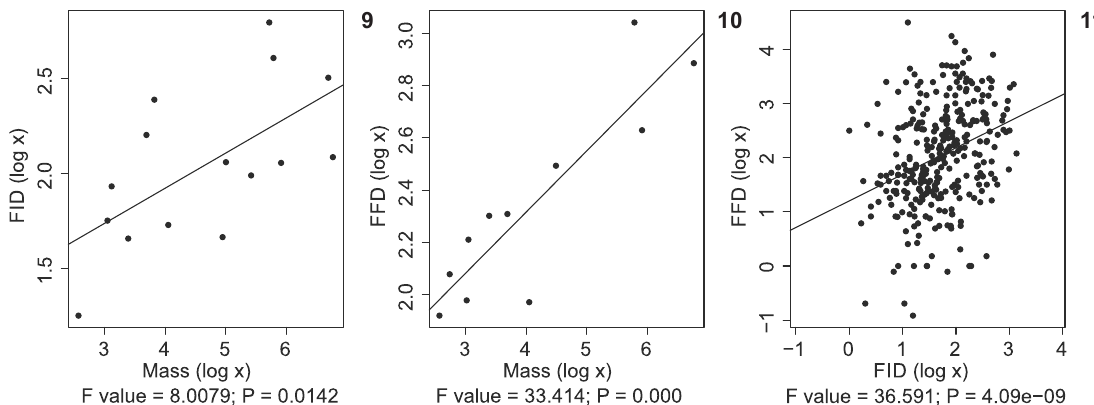
Figures 9-11. Linear regression for (9) Body mass x FID; (10) Body mass x FFD and (11) FID x FFD. Body mass from D UNNING -J R (2008); FID = Flight initial distance (mean for each one of the eleven sampled species); FFD = Flight final distance (mean for each one of the eleven sampled